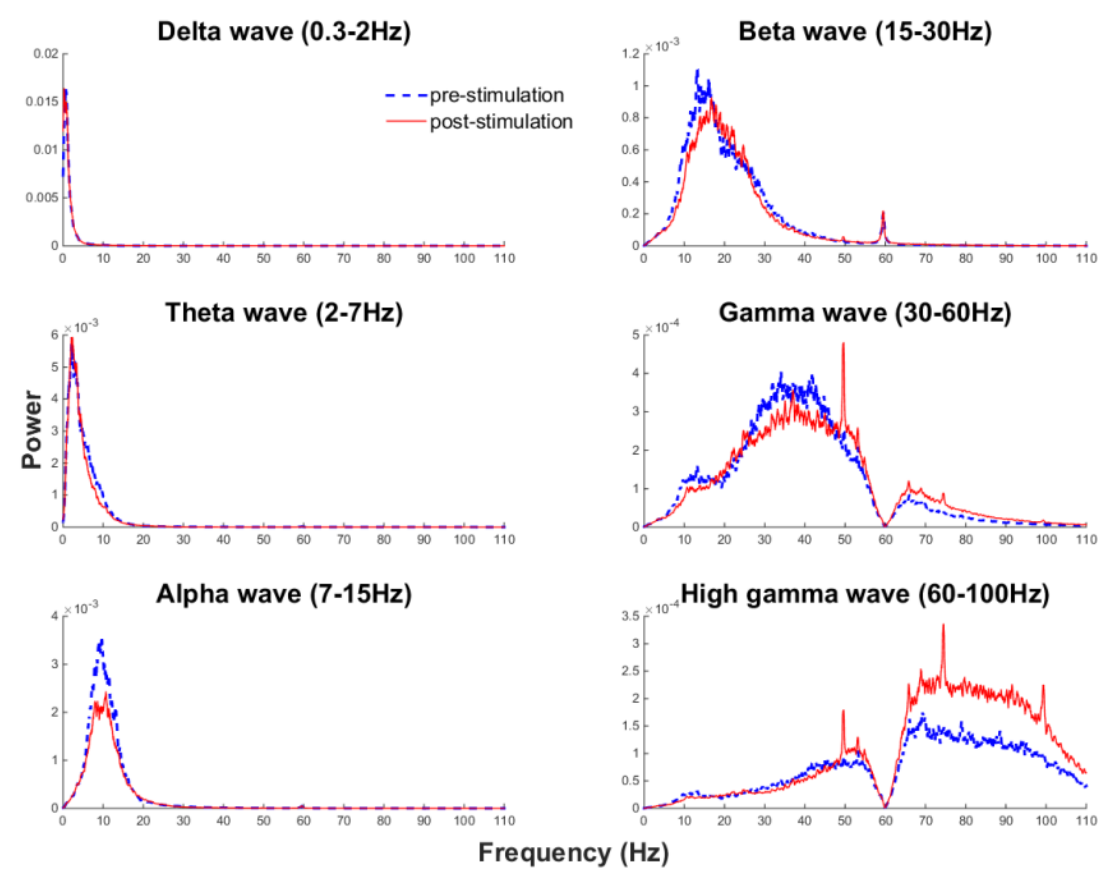
Figure 9. Pre-stimulation and post-stimulation power spectrum changes for each frequency